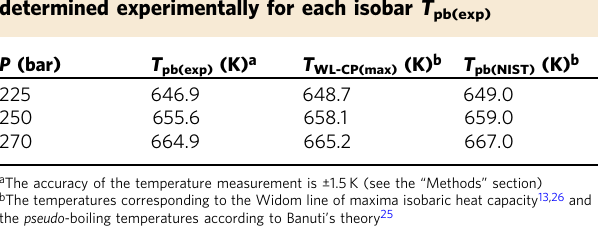
Table 1 The values of the pseudo -boiling temperature determined experimentally for each isobar T pb(exp)